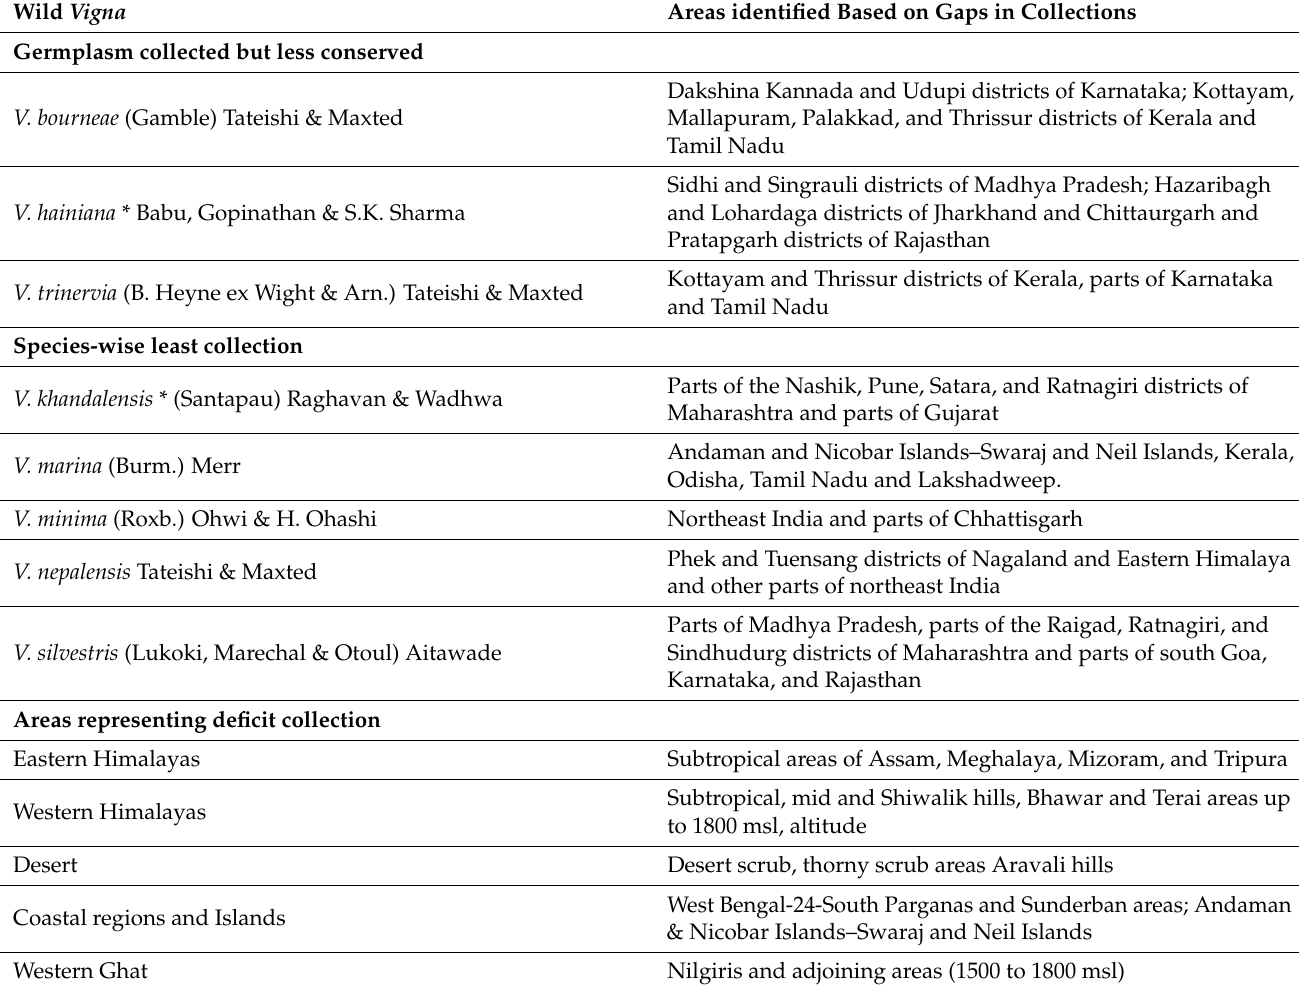
Table 1. Collection gaps and areas identified for the survey, exploration, and expedition of wild Vigna species based on collected and conserved germplasm